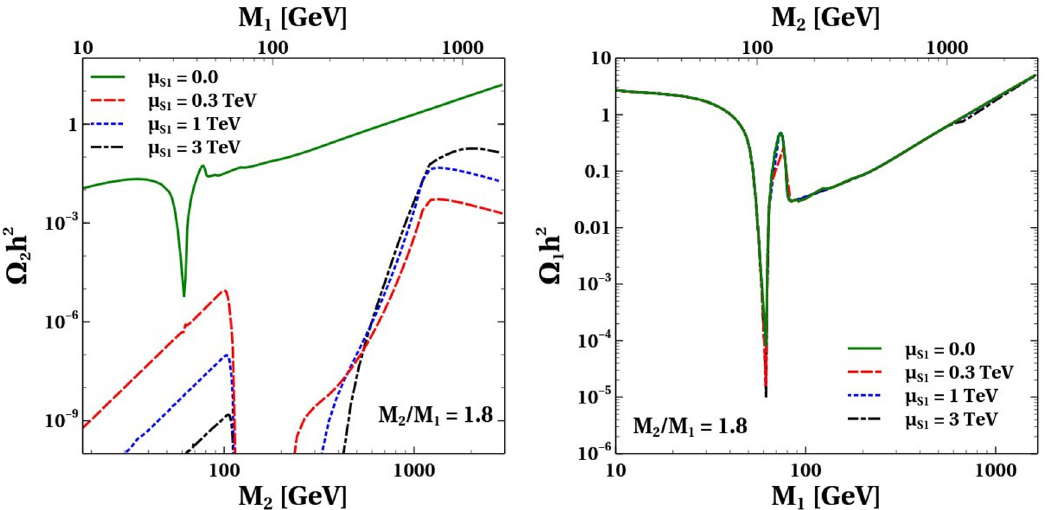
Figure 7 . The e(cid:11)ect of (cid:22) S 1 on (cid:10) 2 (left panel) and (cid:10) 1 (right panel) for M 2 =M 1 = 1 :